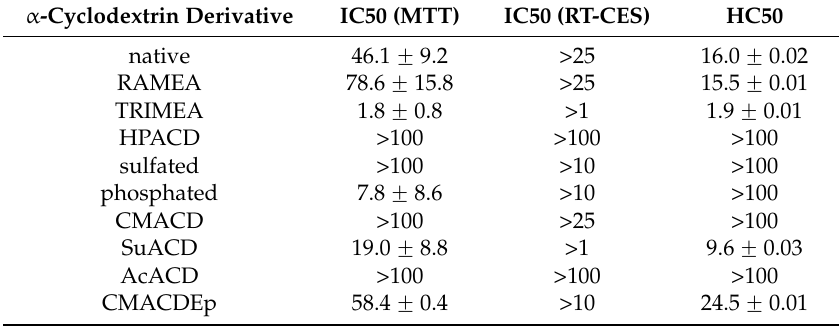
Figure 1. Hemolytic effect of non-ionic ( A ) and ionic ( B ) α -CD derivatives on human red blood cells. Hemolysis was expressed as the percentage of untreated control in the function of α -CD derivatives concentration. Negative control: PBS. Positive control: Purified water. Values presented are means ± SD. All data were obtained from three to five independent biological replicates and in the same experiments, four parallel concentrations were measured. Table 1. Comparison of α -CD derivatives cytotoxicity by different methods (MTT, RT-CES, hemolysis). Values are in mM, and expressed as mean ± SD. All data were obtained from three to five independent biological replicates and in the same experiments four parallel concentrations were measured.